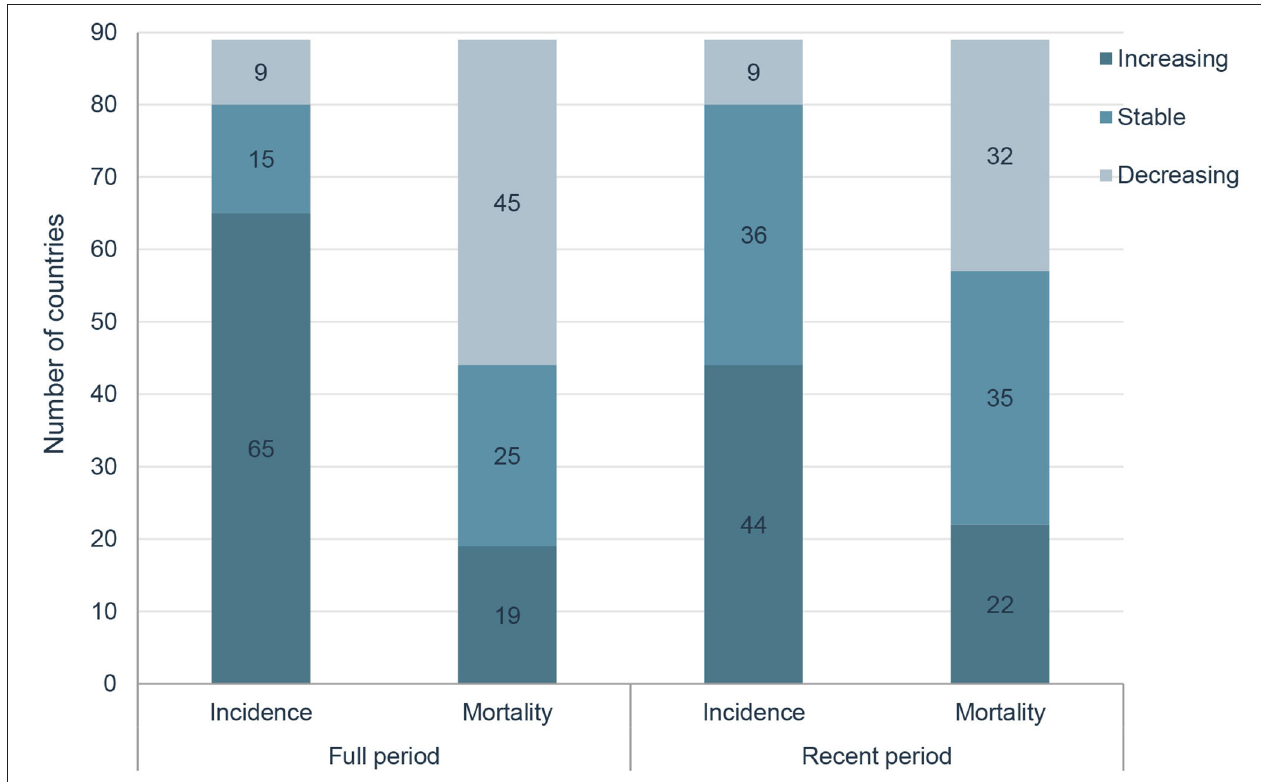
FIGURE 4 | Comparisons of changing trends in most recent period with that in full